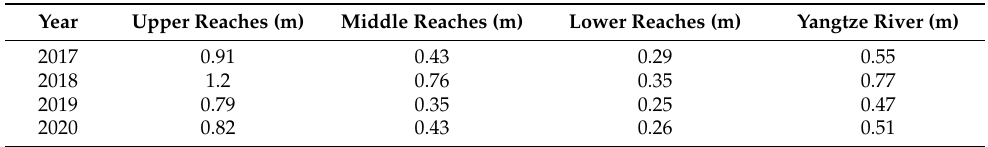
Table 2. The annual mean value results of upper reaches, middle reaches, lower reaches of the Yangtze River